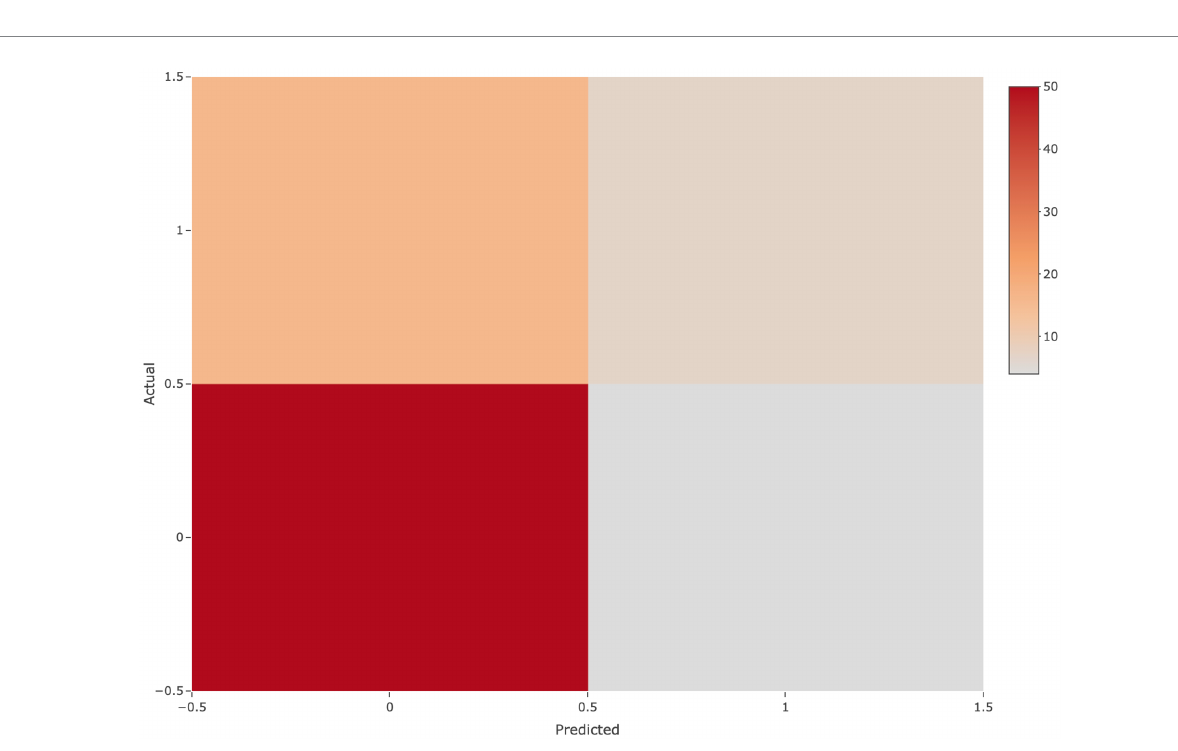
FIGURE 5 Confusion matrix The horizontal axis represents the predicted class, the vertical axis represents the true class, 1 represents the positive class, 0 represents the negative class.